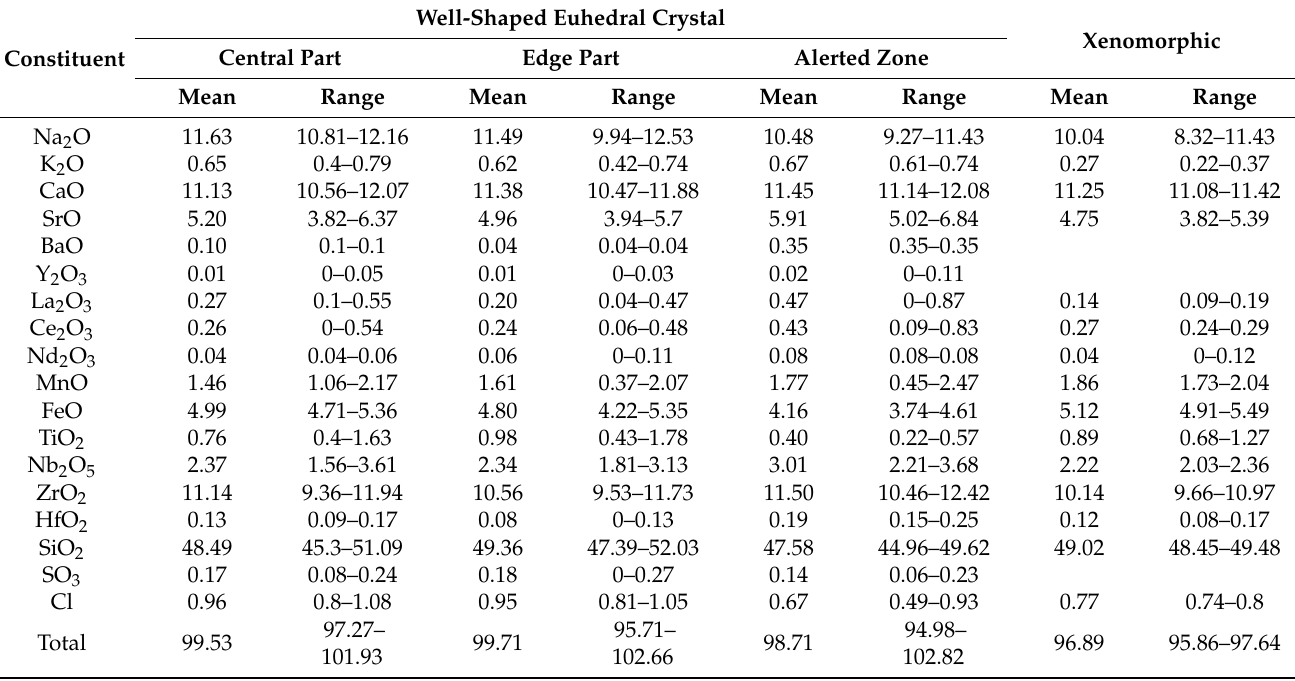
Table 5. In accordance with the classification of EGMs, the studied sample is taseqite. Table 4. Chemical composition (wt.%) of EGMs from Odikhincha massif.